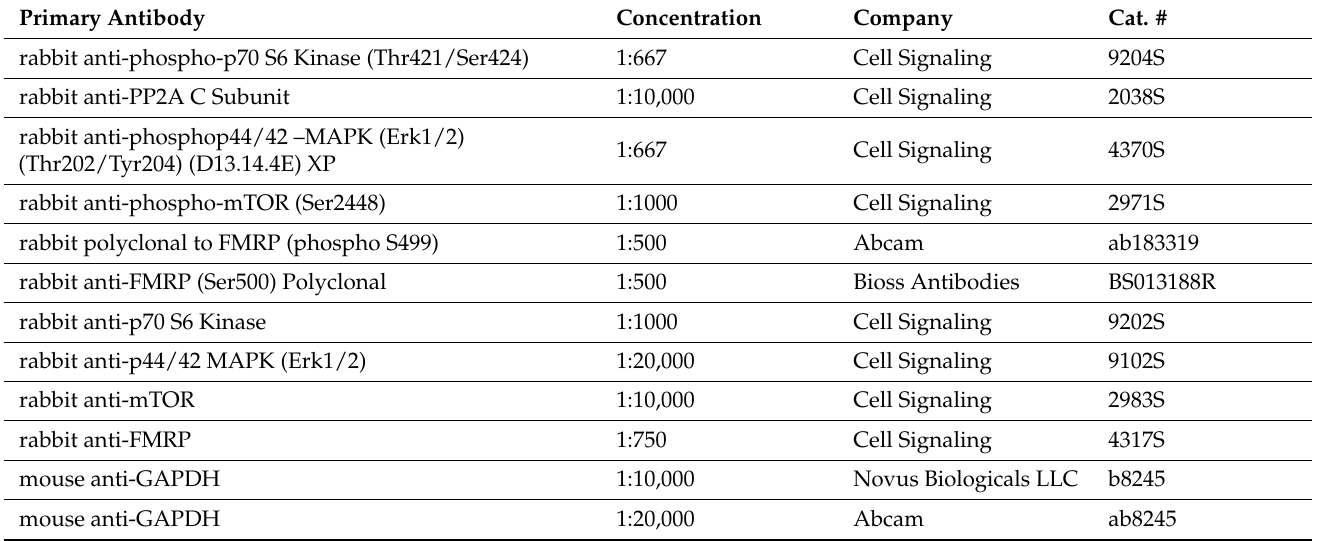
Table 1. Table of primary antibodies, concentration, company and catalog number utilized for this